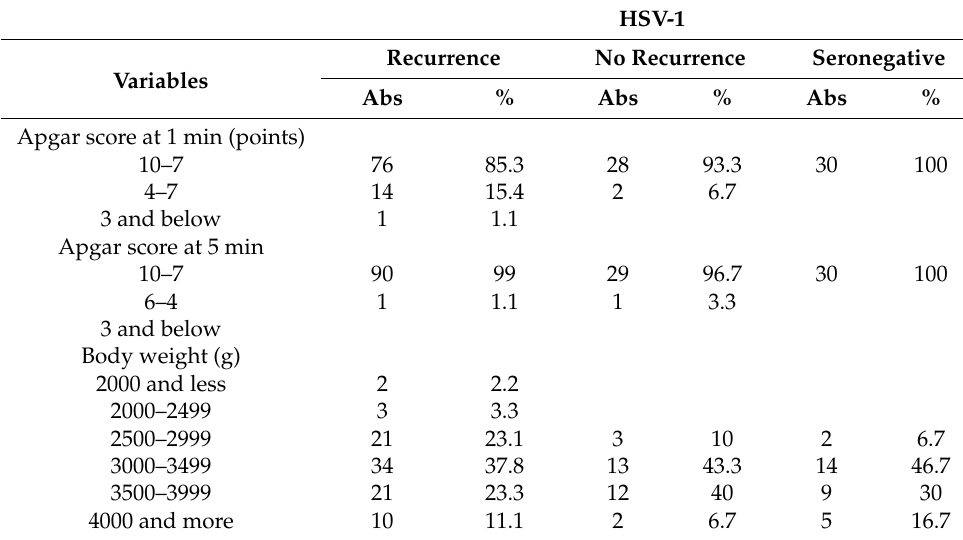
Table 9. Apgar score and weight distribution of newborns in the study